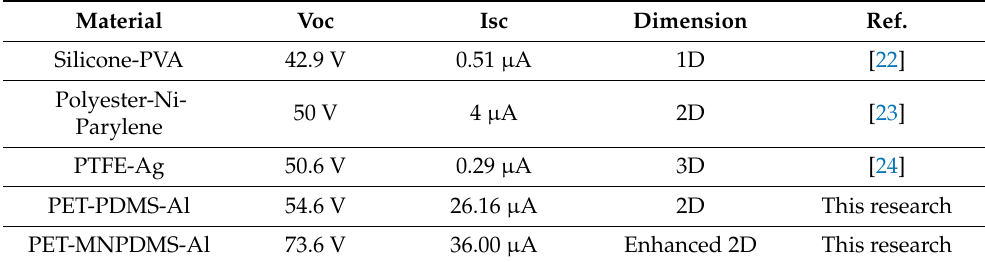
Figure 4. ( a ) Open circuit voltage and ( b ) current diagram of flat surface FTENG and 374 μ m mi- croneedled structure MN-FTENG. Table 1. Comparison of fiber based TENG. Table 1. Comparison of fiber based TENG .